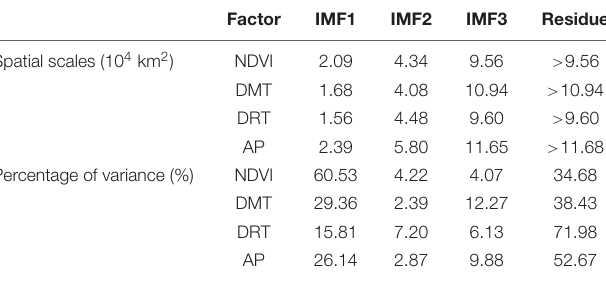
multi-spatial scales, 64.38% of the area had low predictive values and 35.28% had high predictive values. Thus, the accuracy of predictions based on the climatic factors at the multi-spatial scale was generally higher and was mainly located in the northwest and south of